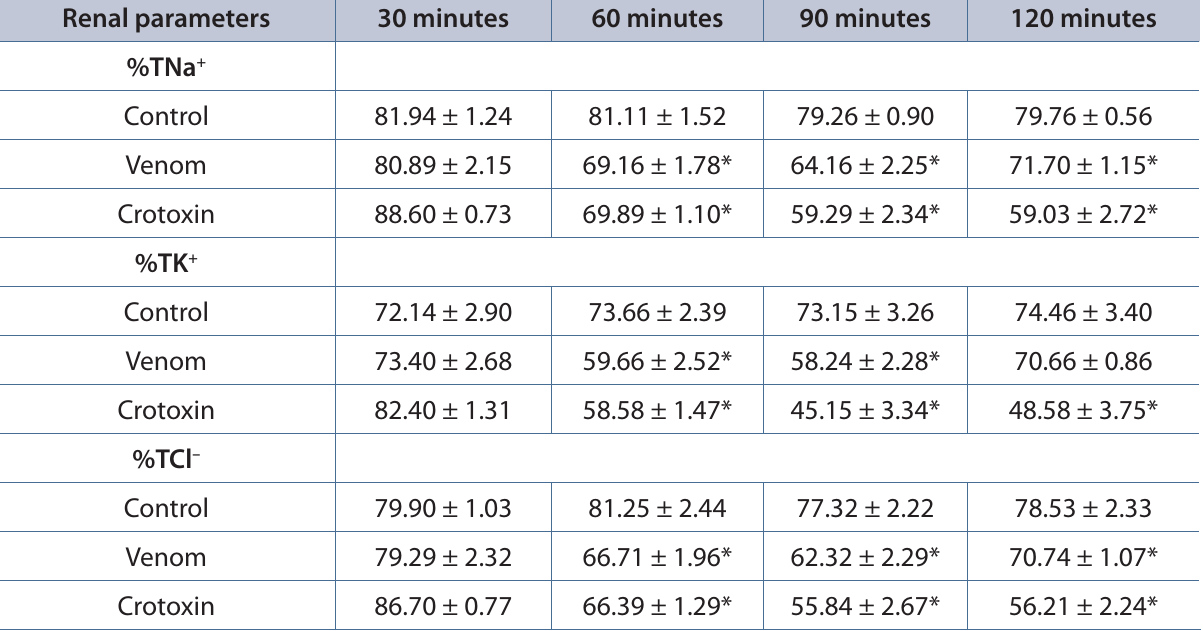
Table 1. Effects of Crotalus durissus cumanensis venom and crotoxin on electrolyte transport in isolated kidney